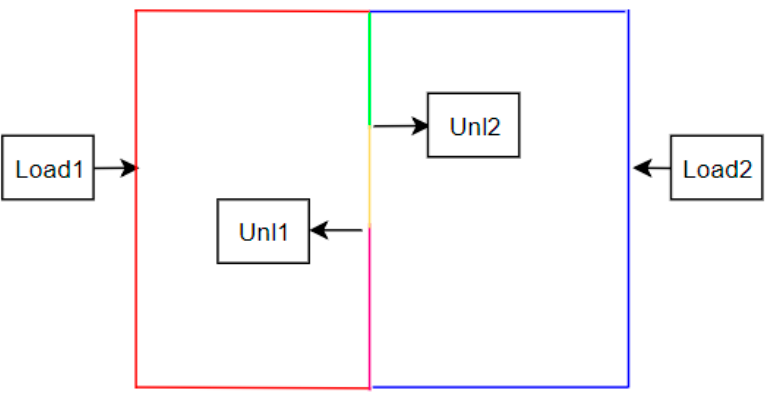
Figure 15. Case IV: di ff erent sectors for the automatic guided vehicle (AGV) network.